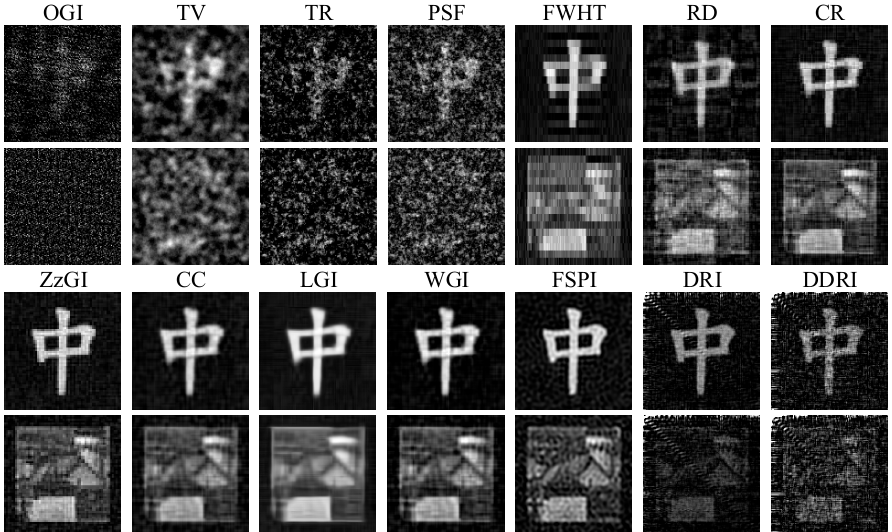
Figure 9. Experimental results of fourteen GI methods in the general environment (without WT).